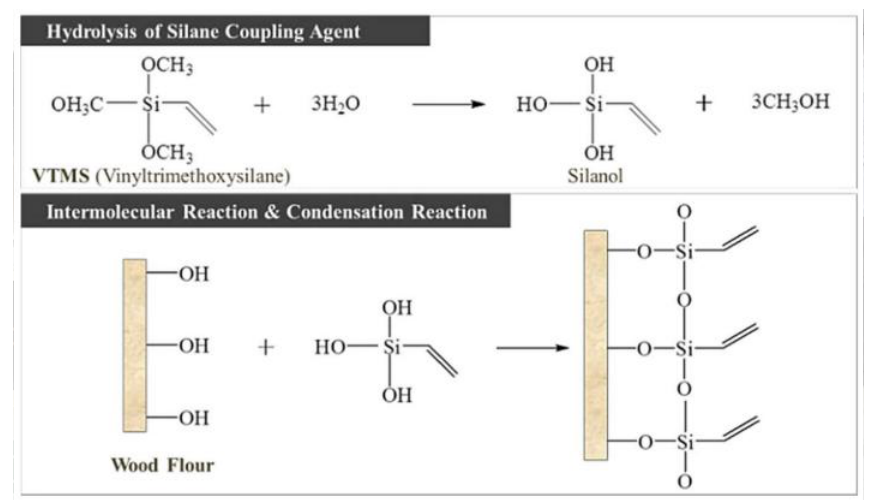
Figure 2. The mechanism for hydrophobic modification reaction of wood flour (WF).